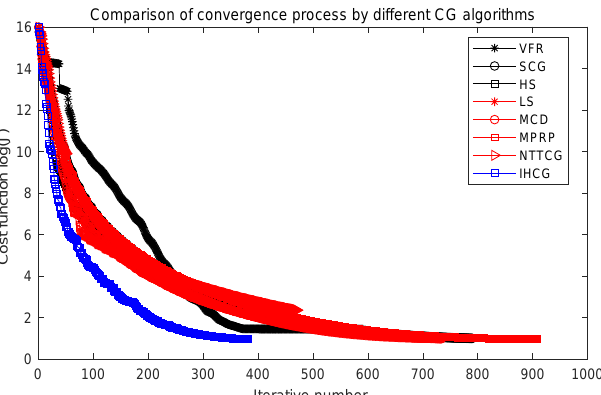
Figure 8. Comparison of convergence process log ( J ) by different CG algorithms ( δ = 0.01).